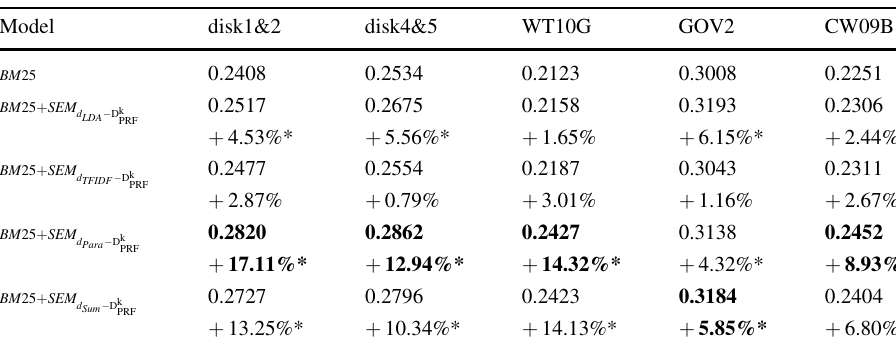
Table 11 Comparison to BM25